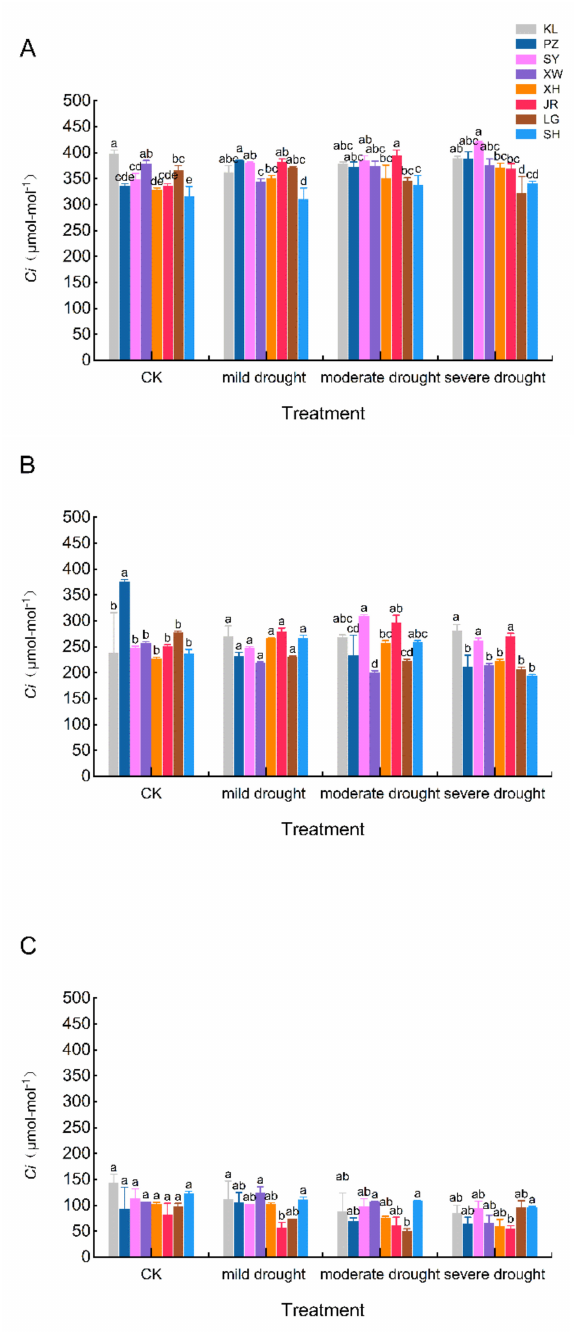
Figure 5. The intercellular CO 2 concentration of Melia azedarach among different provenances: ( A ): early stage, ( B ): middle stage, and ( C ): late stage. Note: The error line in the figure is the mean ± standard error, and different lowercase letters in the same treatment indicate significant differences at the 0.05